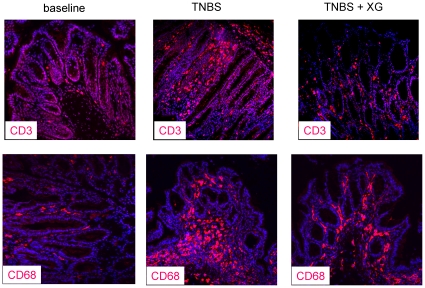
Representative CD3 and CD68 immunofluorescence.Representative CD3 (left) and CD68 (right) immunofluorescence of the distal colon from normal mice, trinitrobenzene sulfonic acid (TNBS) administration and treatment with sc. 100 µg/kg XG-102.